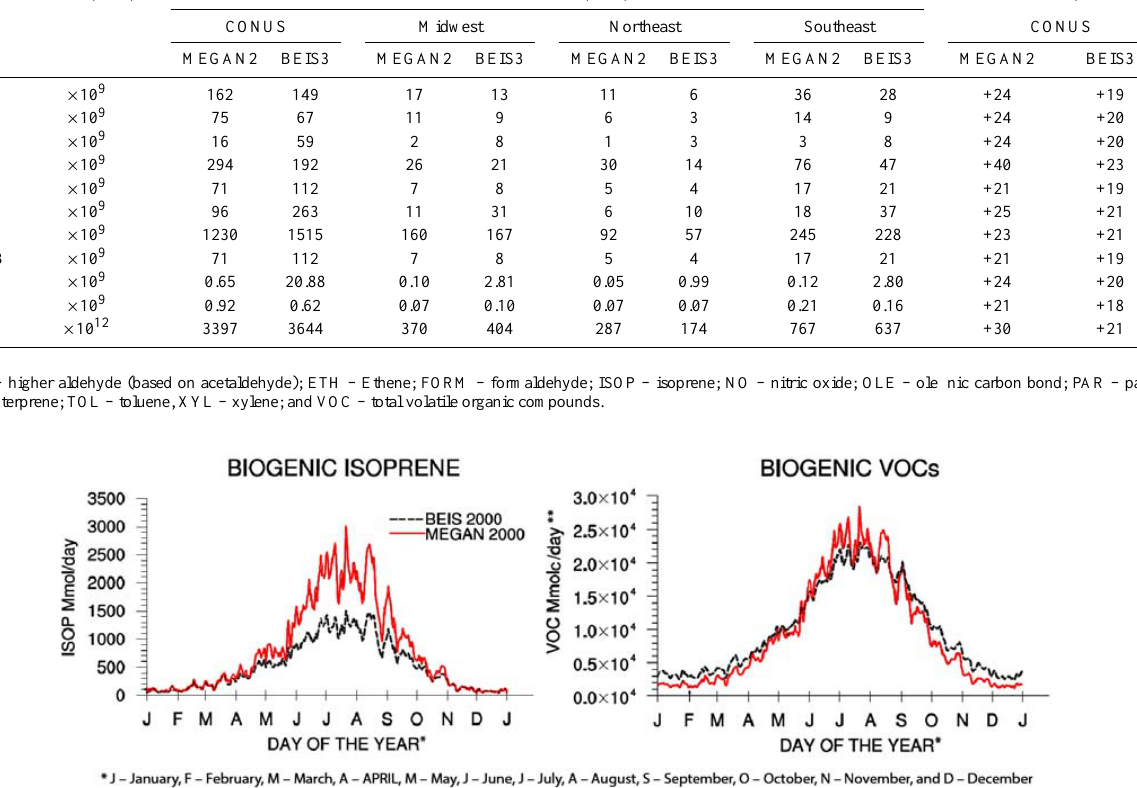
Table 3. The breakdown of species concentrations of the present-year biogenic emissions from BEIS3 and MEGAN2, with comparisons of the present-year (2000) and future-year (2050) biogenic emissions.